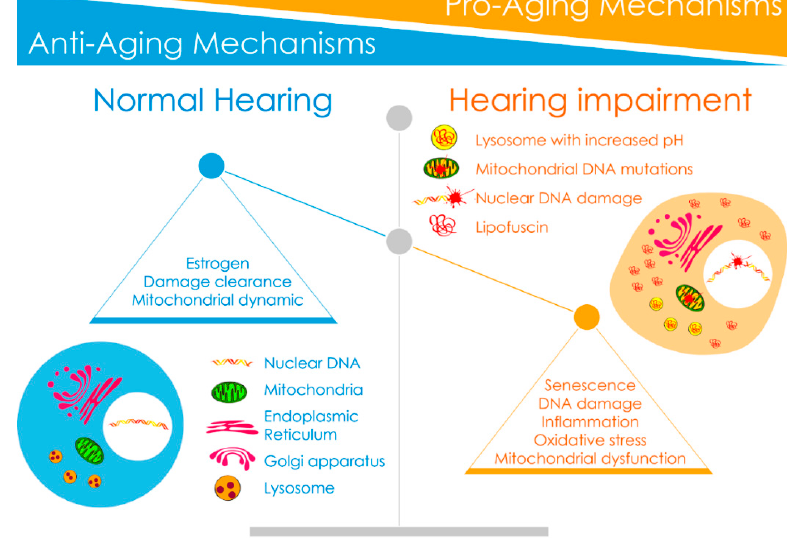
Figure 3. Imbalance between anti-aging and pro-aging mechanisms with age . The scheme